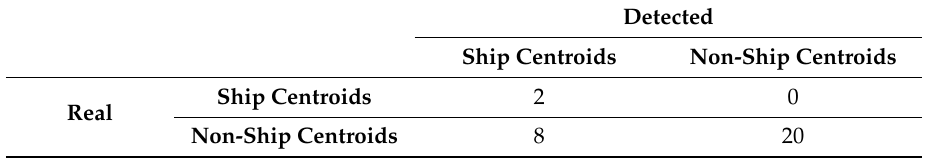
Table 2. The confusion matrix of real and detected ship centroids using the maximum entropy